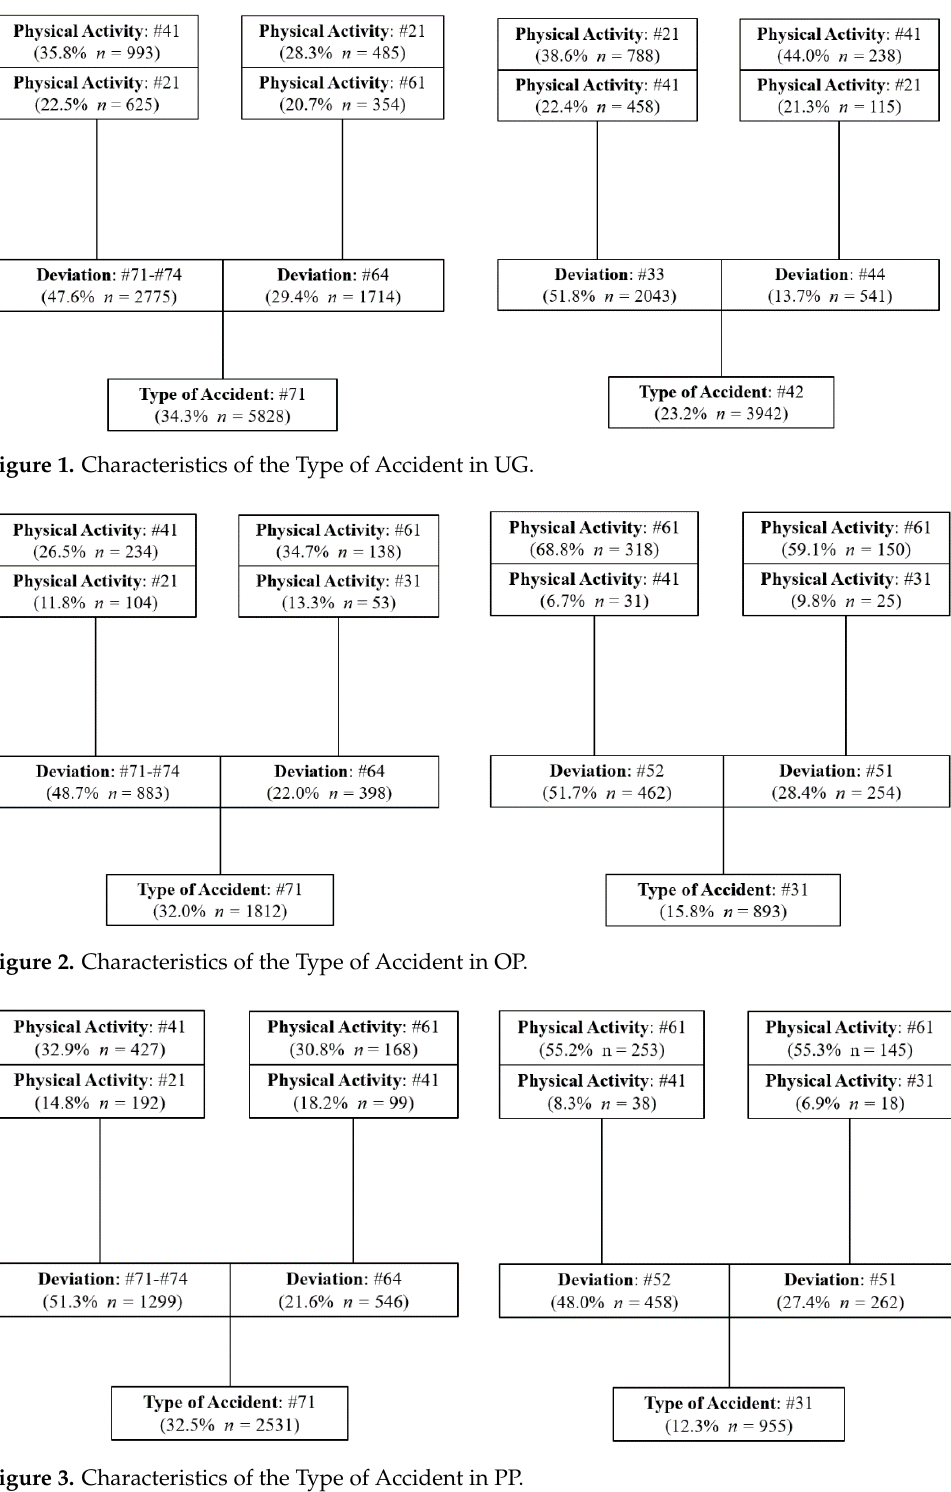
Figure 3. Characteristics of the Type of Accident in PP.